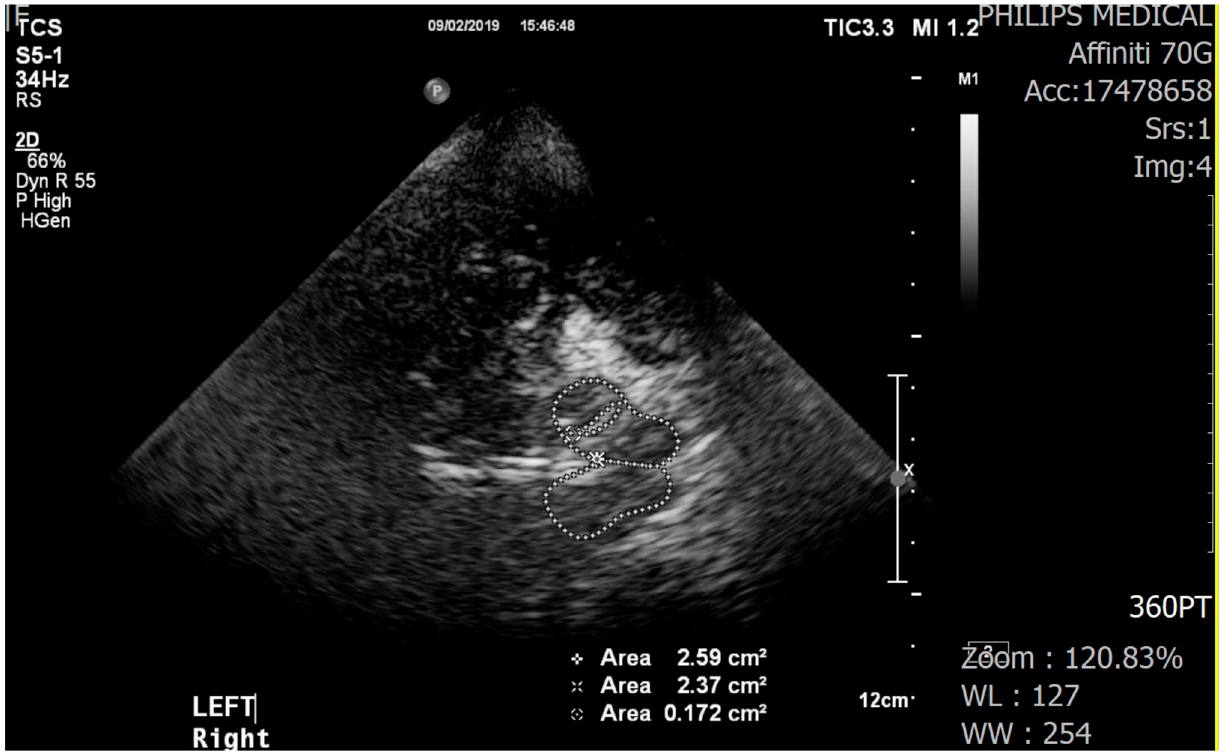
Figure 1. Transcranial sonography images of the midbrain (butterfly-shaped, left and right) and hyperechogenicity of the substantia nigra (encircled by the dotted line, inside the midbrain).